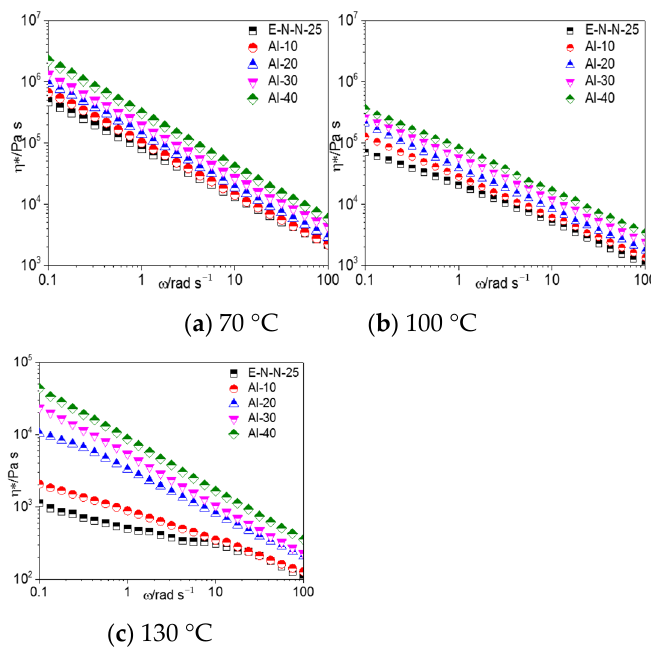
Figure 5. η *– ω curves of model propellants with different Al powder contents.